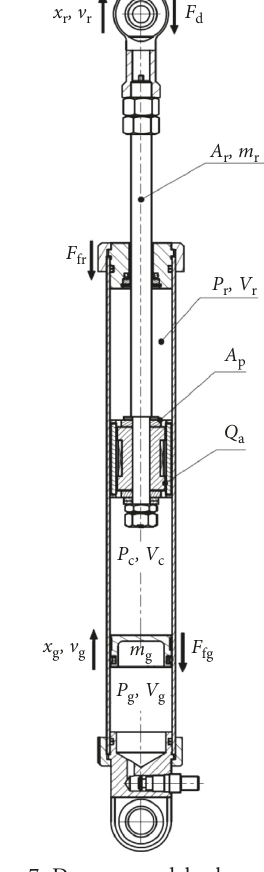
Figure 7: Damper model schematic layout.